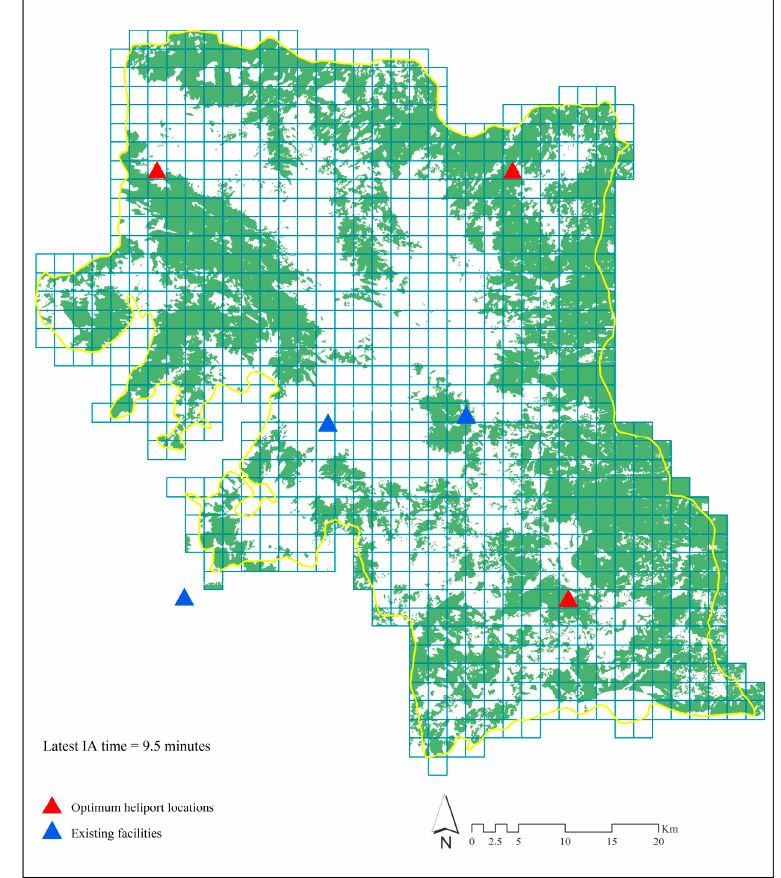
Figure 19. Visualization of s6. Table 2. Grid numbers of optimum heliport locations in the Pareto optimal solution.